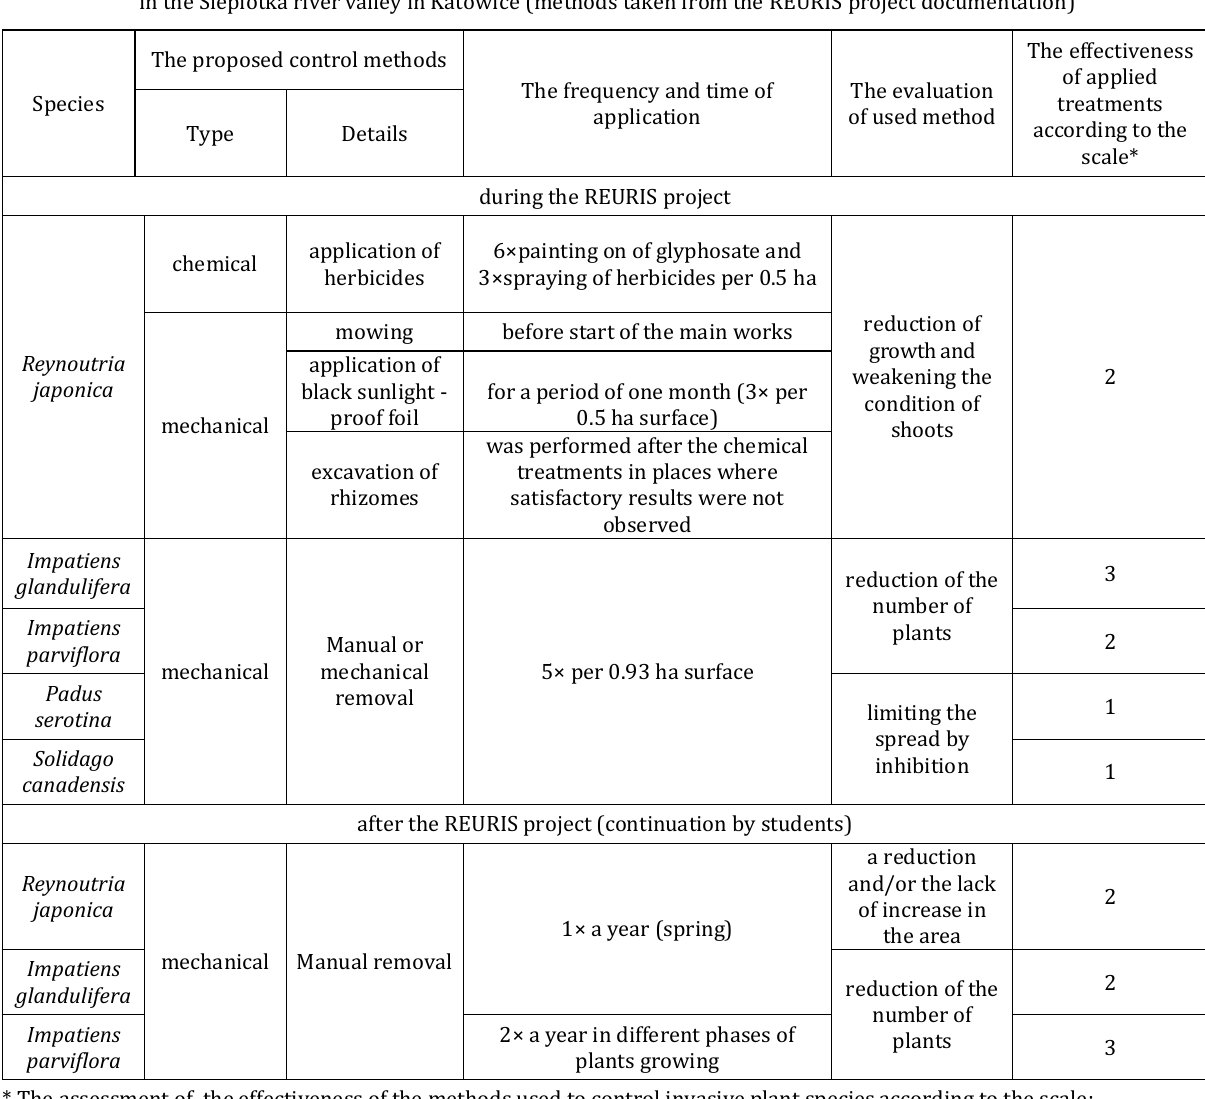
Table 1. Characteristics and an assessment of the effectiveness of the methods used to control invasive plant species in the Ślepiotka river valley in Katowice (methods taken from the REURIS project